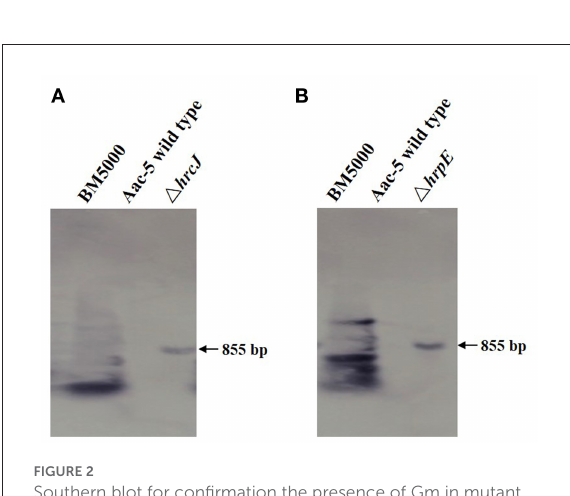
FIGURE2 Southern blot for confirmation the presence of Gm in mutant strains of A. citrulli . The 1 hrcJ (A) and 1 hrpE (B) strain showed an 855-bp band on gel, while the wild type strain showed no band, indicating the mutant strains harbored a Gm cassette. leaves infiltrated with the complementation strains hrcJ -comp and hrpE -comp, as compared to those with the wild-type strain Aac-5 of A. citrulli (Figures 3A4,B4).